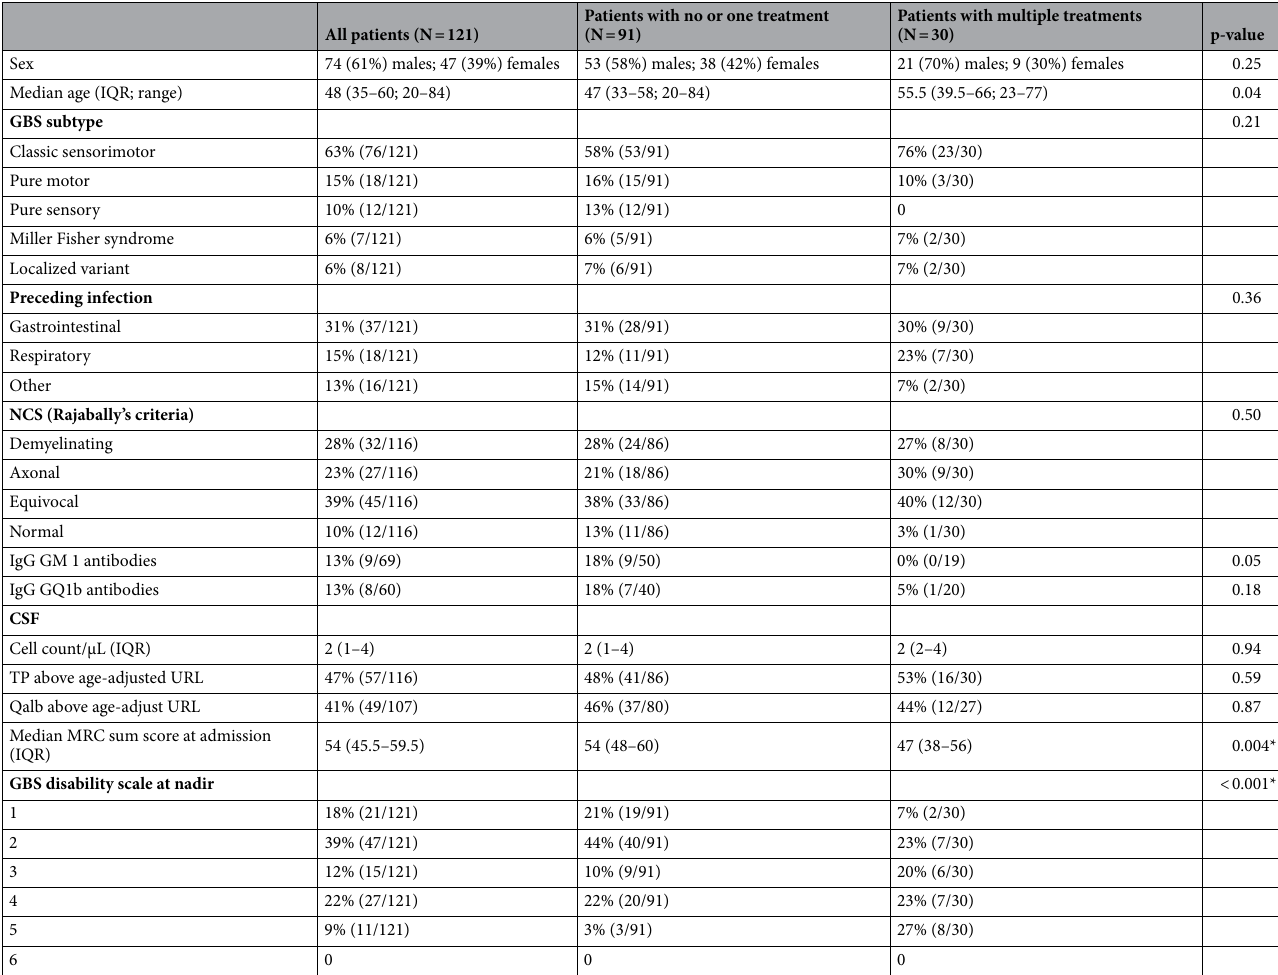
Table 1. Clinical characteristics. Clinical features of all patients as well as for patients with no or one treatment versus patients with multiple (2 or more) treatments as well as univariate comparison between the two groups are shown. MRC sum scores were calculated at admission and GBS disability scale at nadir. Upper reference limits for age-adjusted total protein were calculated according to McCudden et al. 17 and for